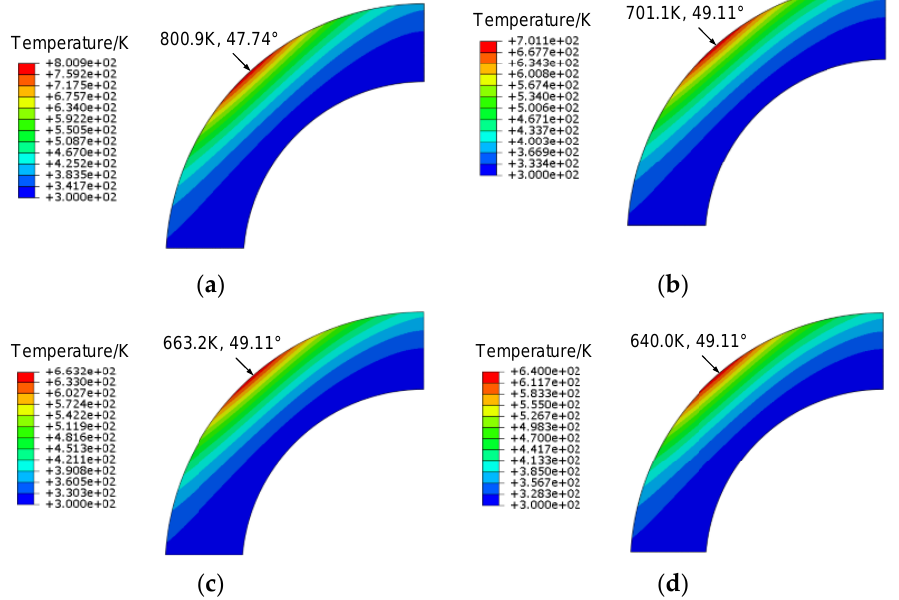
Figure 17. Comparison of the structural temperature field of the forebody at 20 s: ( a ) L / D = 0.5; ( b ) L / D = 1; ( c ) L / D = 1.5; ( d ) L / D = 2.